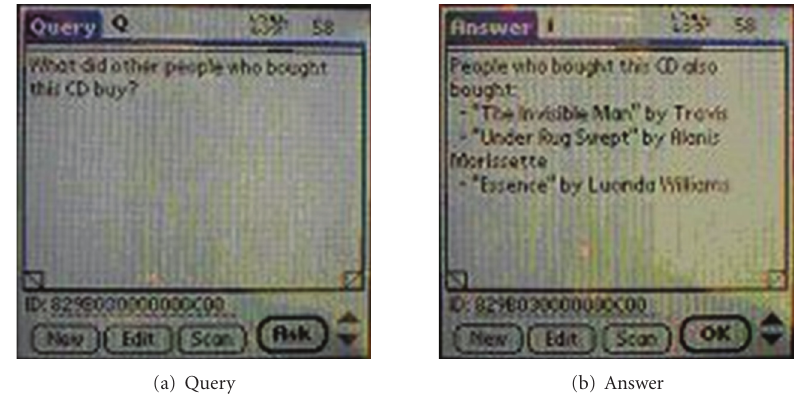
Figure 2: Graphical user interface of